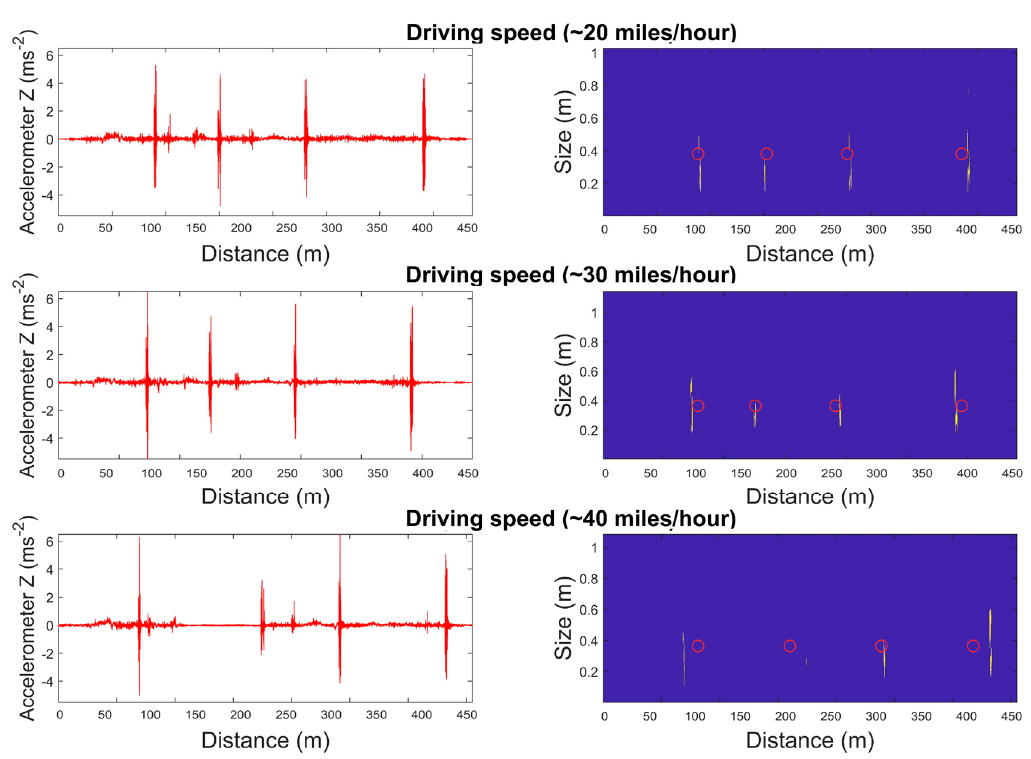
Figure 8. Results generated from three driving tests with different driving speeds.